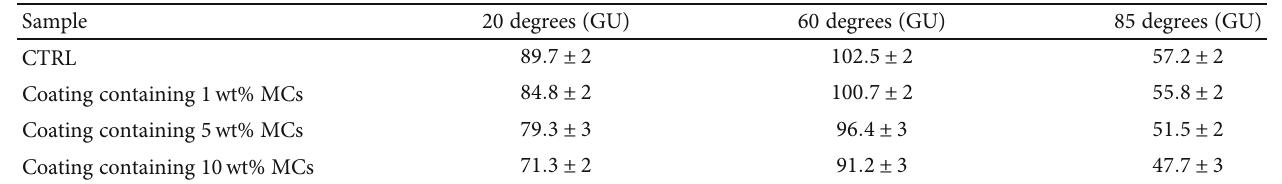
Table 5: The results of the gloss measurement for prepared